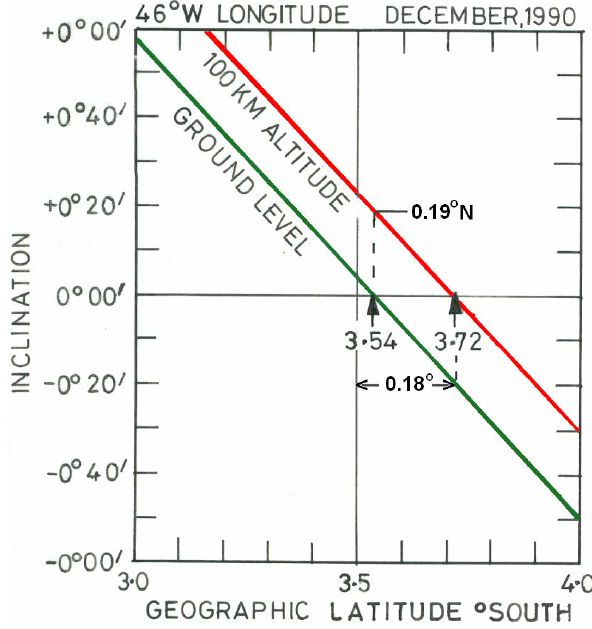
Fig. 9. Variation with geographic latitude of the inclination of field lines at the ground and ionospheric levels for 46 ◦ W geographic lon-